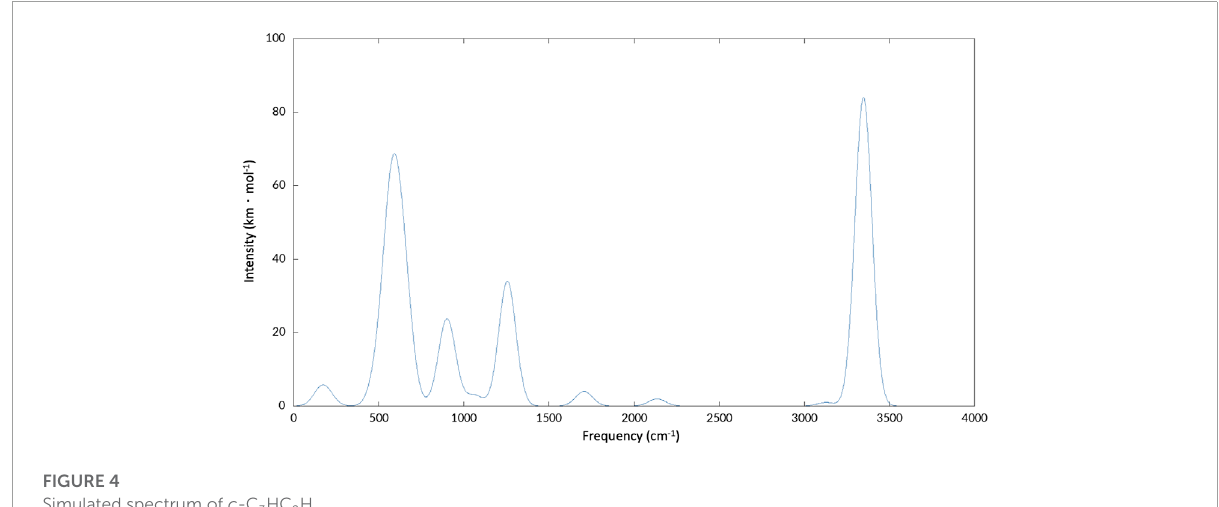
FIGURE 4 Simulated spectrum of c -C 3 HC 2 H.